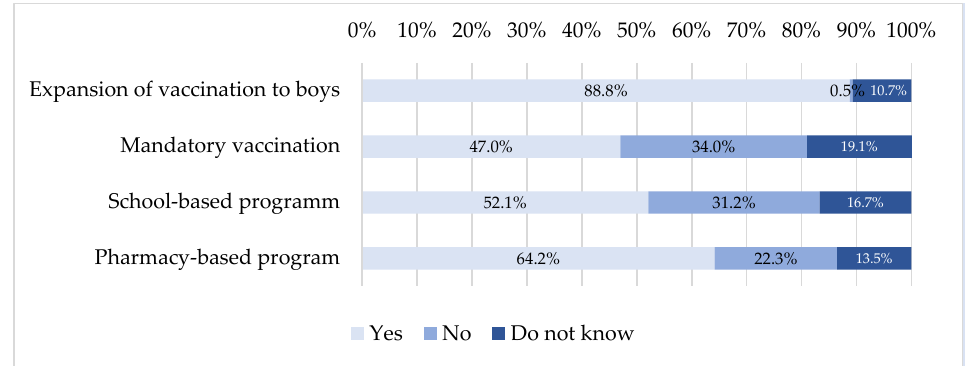
Figure 4. Expansion of recommendations and perspectives.